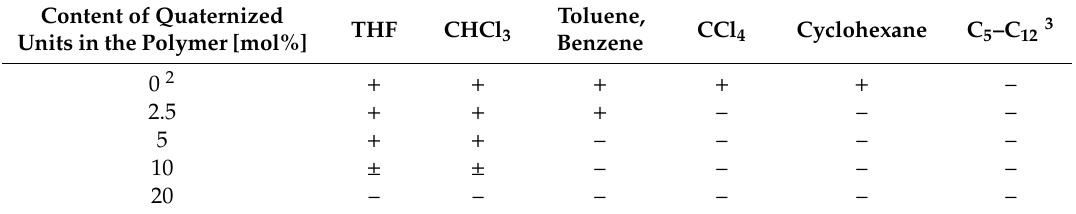
Table 2. Solubility of PTMSP with different contents of butylimidazole units towards organic solvents 1 . Content of Quaternized Units in the Polymer